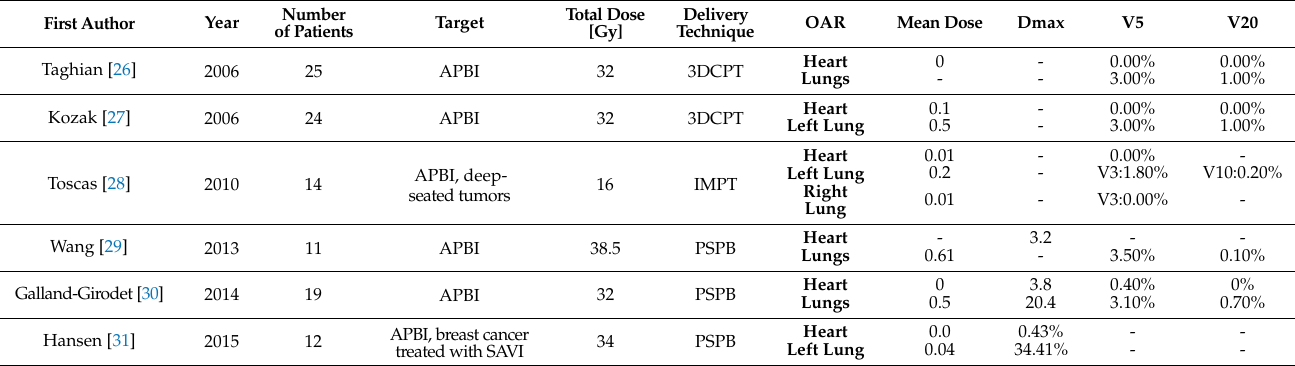
Table 1. Dosimetry of dose distribution for accelerated partial breast irradiation, taking into account the parameters of mean dose, Dmax, V5, and V20 in OAR (heart and